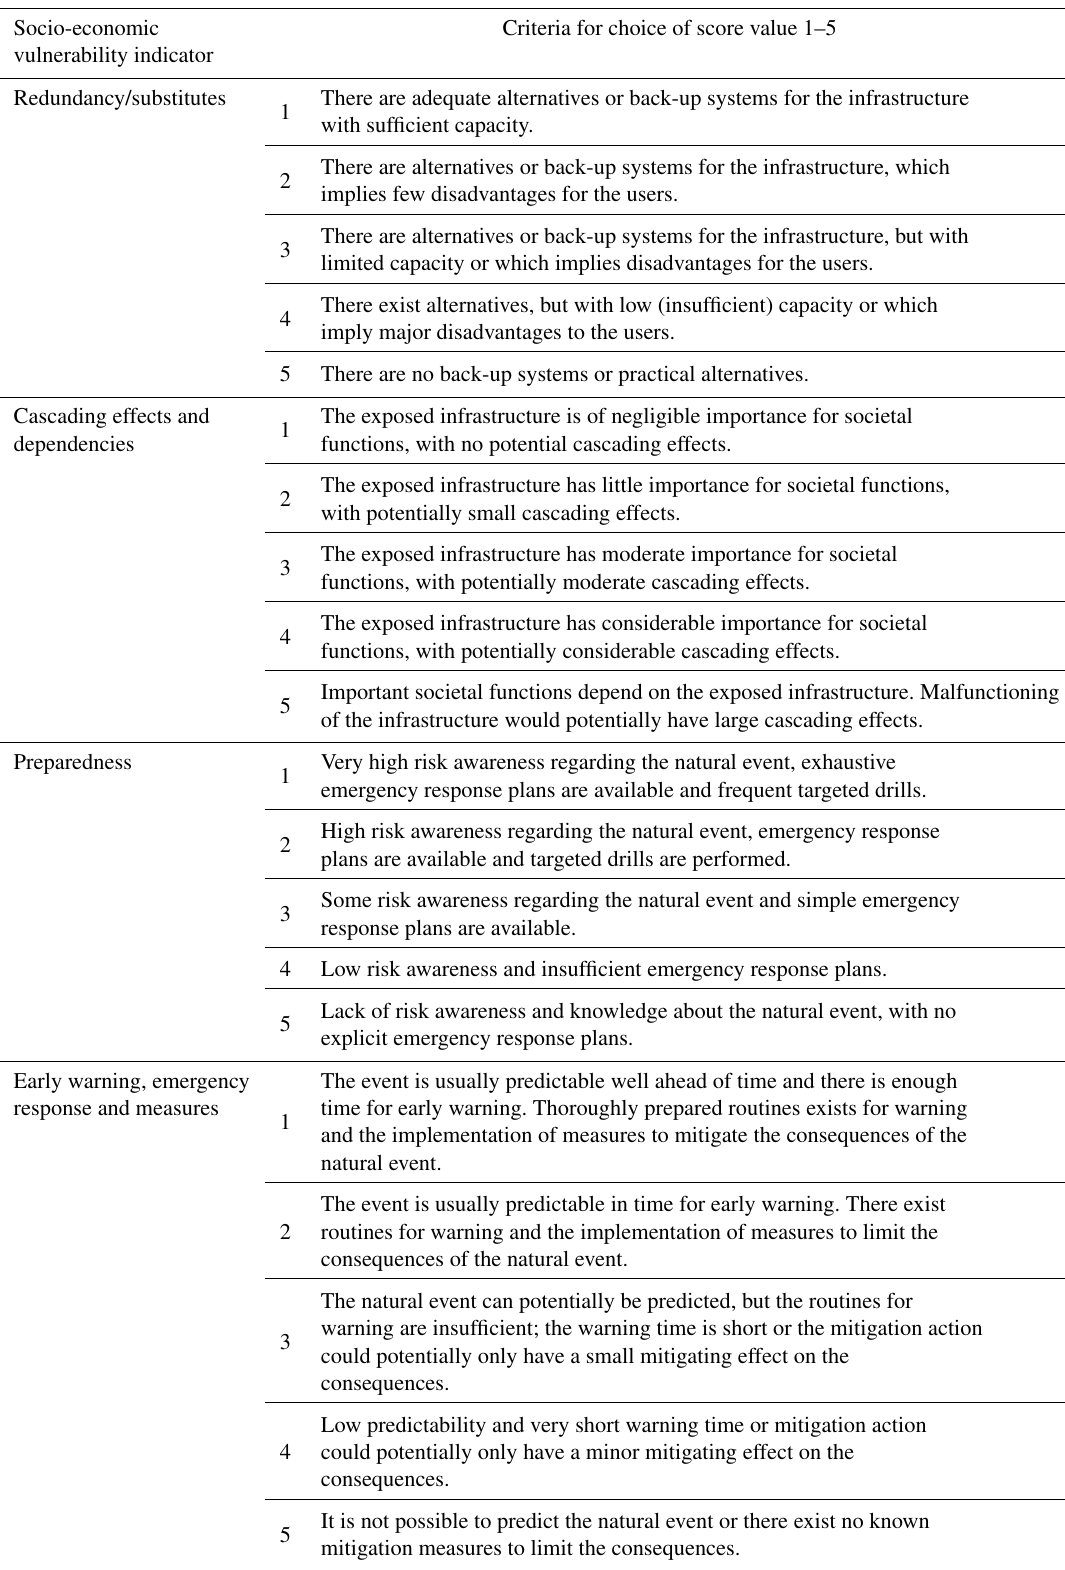
Table 5. Criteria for ranking of socio-economic vulnerability indicators. For each indicator, the criteria for score values 1–5 are described, where score value 1 corresponds to the lowest vulnerability and 5 to the highest